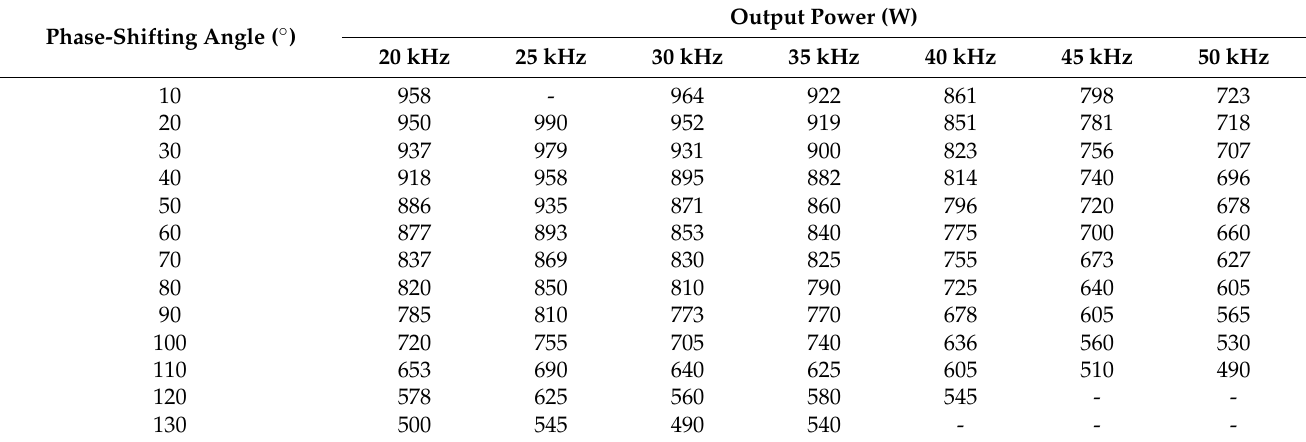
Table 3. Power regulation test data